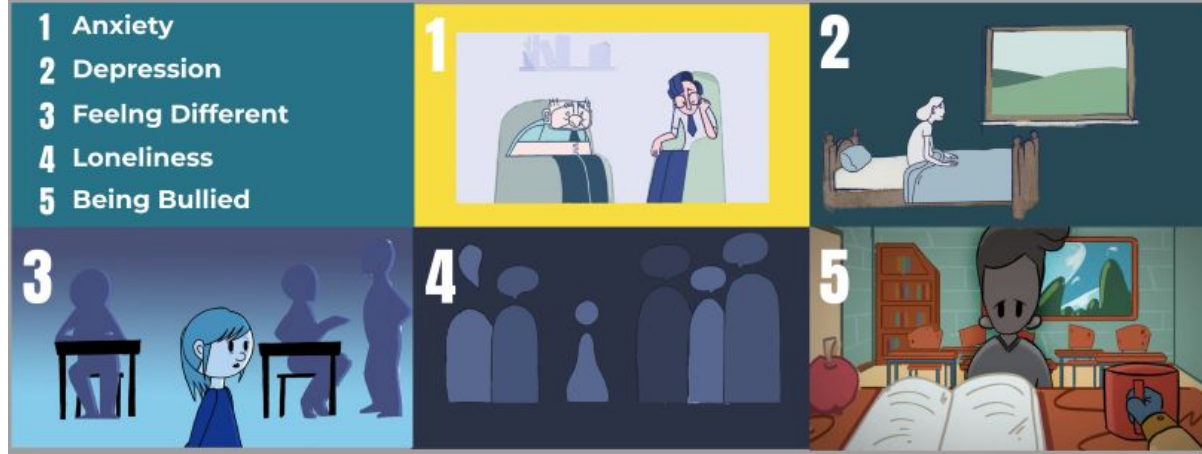
Figure 1. Screenshots from each of the 5